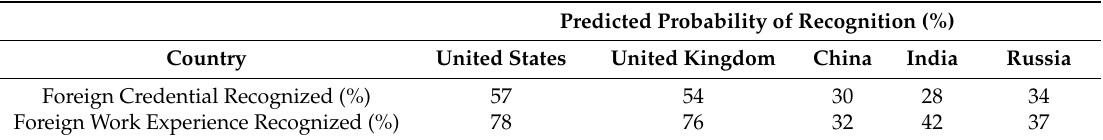
Table 5. Recognition of Foreign Credential and Work Experience among Immigrants from Different Countries (Houle and Yssaad